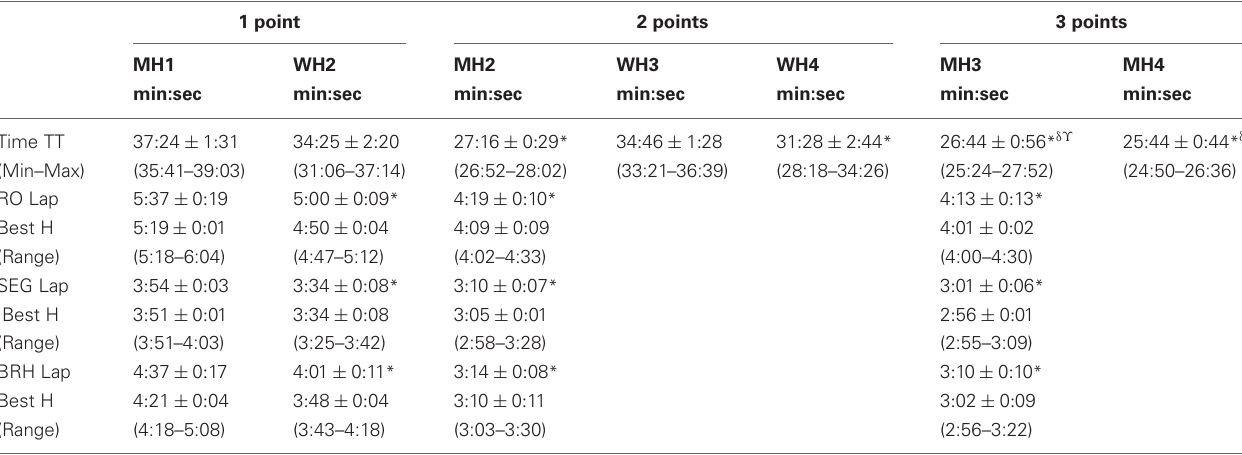
Table 1 | Time (in min:sec ± SD) of the 5 first final time trial (16km) for division H1–4 men and women during the paralympic games in brands Hatch, the 5 September 2012. 1 point